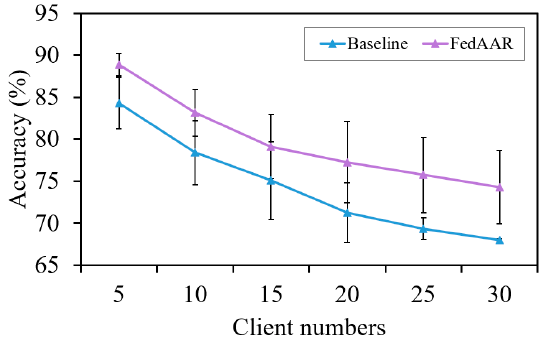
Figure 6. Testing accuracy of FedAAR and its baseline over various client